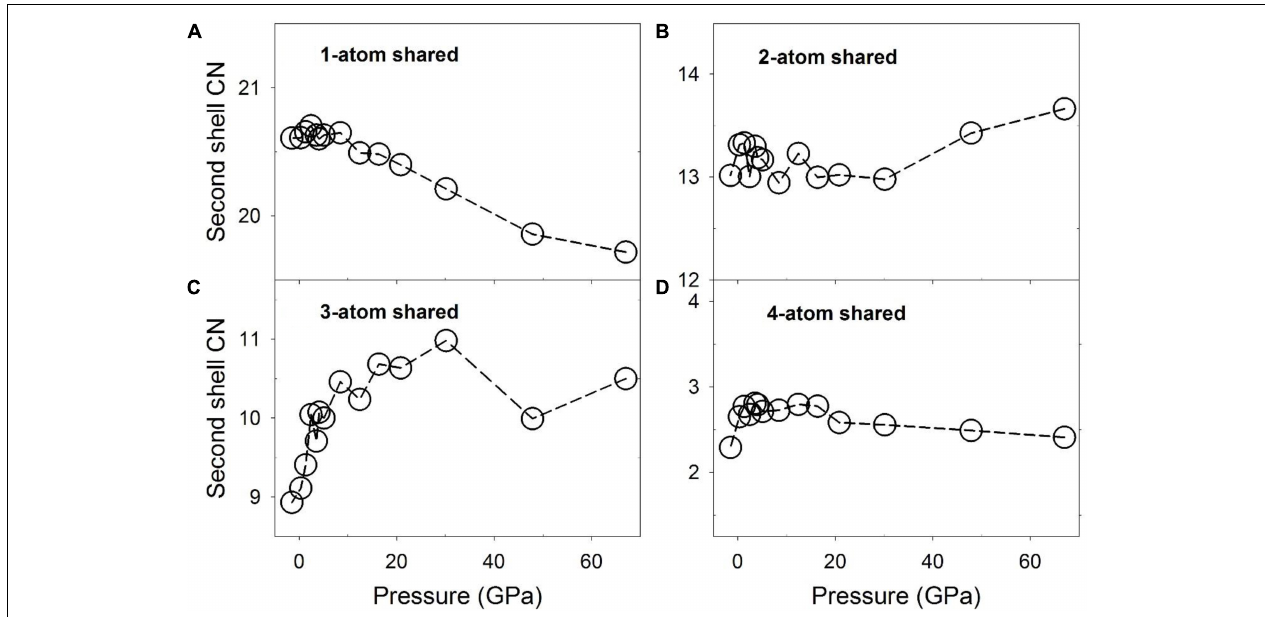
FIGURE 6 | Coordination numbers (CNs) of Fe/Ni-Fe/Ni associated with partial configurationally decomposed PDFs as a function of pressure. (A) 1-atom corner-shared, (B) 2-atom edge-shared, (C) 3-atom face-shared, and (D) 4-atom shared connections.